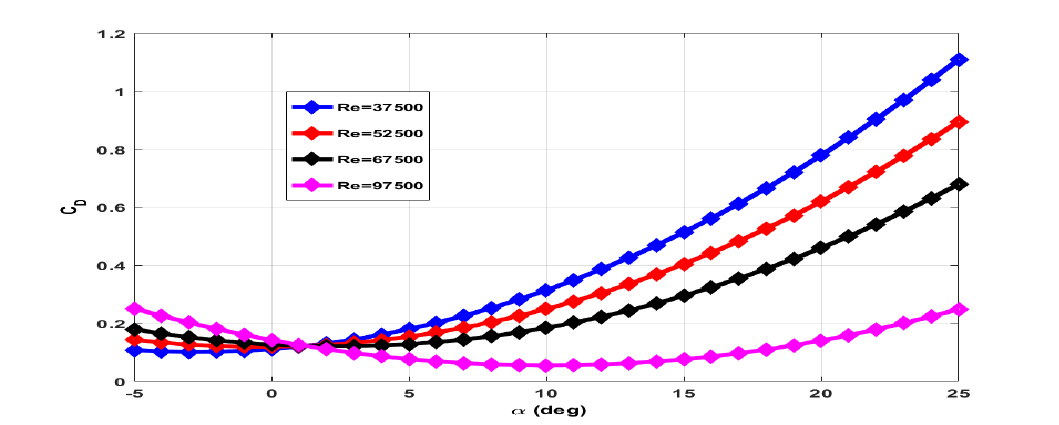
Figure 9. Coefficient of drag at 0 ◦ elevator deflection and zero propeller RPM.